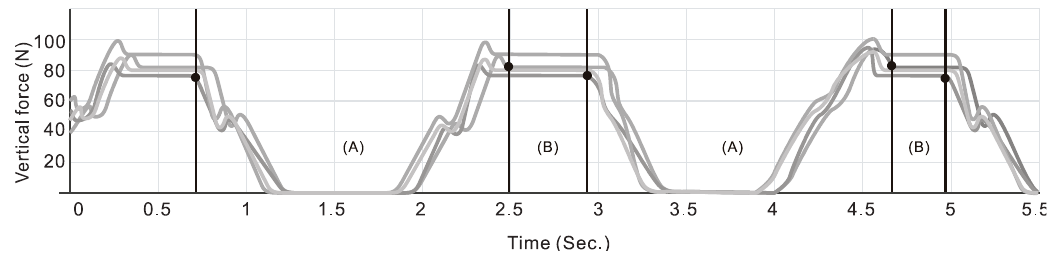
Figure 2. Stance phase ( A ) and swing phases ( B ) for each step.